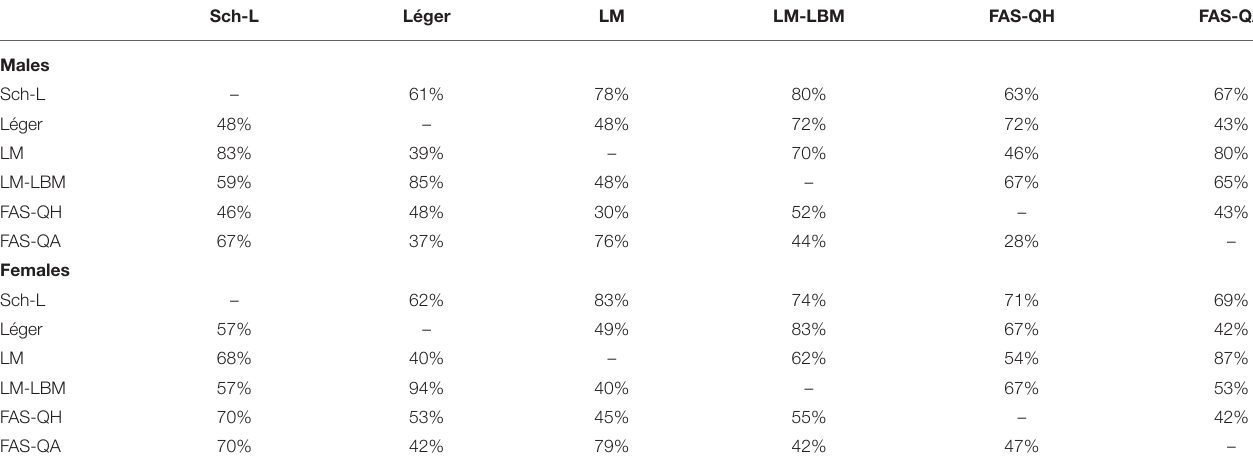
TABLE 4 | Consistency between pairs of equations in assigning males and females into the ≤ 5th percentile (the upper right corner) and into the ≥ 95th percentile (the lower left corner) of each eGFR distribution. Sch-L Léger LM